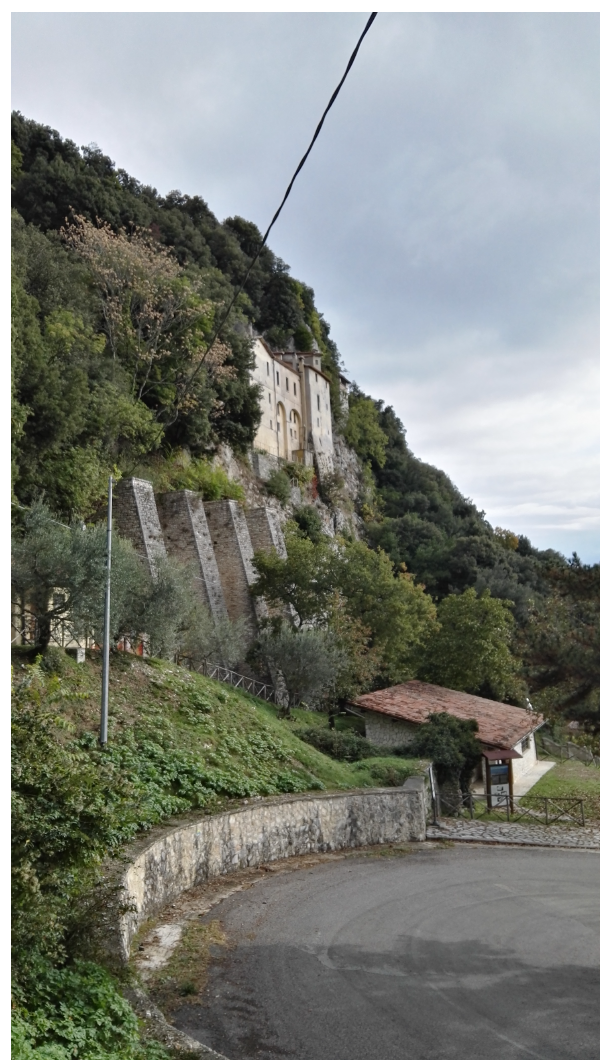
Figure 10. View of the monastery in Greccio, Italy, and the lo- cation of the first living nativity scene organized by St. Francis in 1223. The monastery is located along a thrust fault and is built on carbonate units of the Sabina sequence (Meso-Cenozoic). See the geologic map in Fig. 5. Photo credit: Ann C.